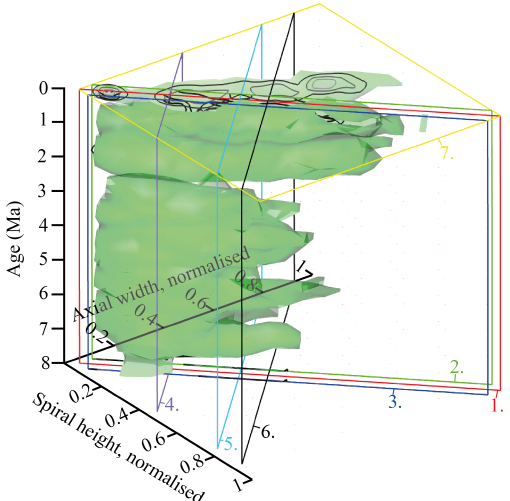
Figure A2. VDD of normalised spiral height ( δX ) versus normalised axial length ( δY ) during the past 8Myr for G. menardii . The position of the vertical frontal and sagittal sections shown in Figs. 10 and A3–A7 are indicated as coloured planes. The iso-surface (value = 0.89447168) represents the density of one specimen per grid cell. The red frontal section 1 is that of Fig. 10. Frontal section 2 (green) has an offset value of − 0.05 (away from the reader; see Fig. A3). Frontal section 3 (blue) has an offset value of + 0.05 (towards the reader; see Fig. A4). Sagittal section 4 (violet, offset =− 0.55; Fig. A5), sagittal section 5 (light blue, offset value =− 0.23; Fig. A6) and sagittal section 6 (black, offset =− 0.1; Fig. A7) are orthogonally positioned in comparison to sections 1, 2 and 3. The yellow transversal plain at 0.003Ma (7) shows the aberrant orientation of the contour frequency diagram in sample 667A-1H-1, 3–4cm (see text). The black lines represent contour intervals of 3.